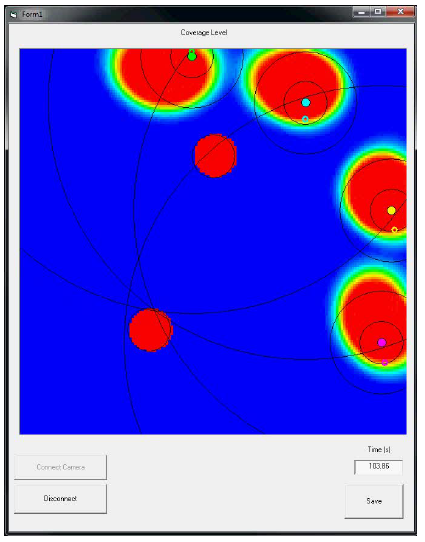
Fig. 11. Robot used in the multi-robot experiments. Fig. 12. Dynamic coverage visualization